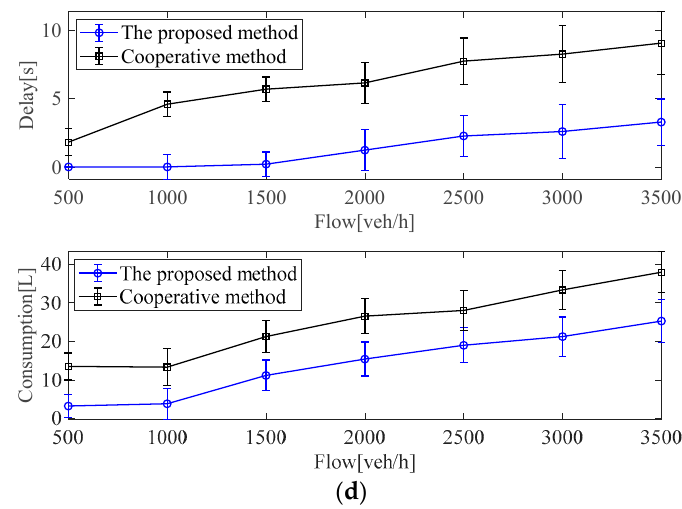
Figure 10. Test results with two methods under different traffic flow conditions in the intersection subregions: ( a ) test results in the intersection subregion N5; ( b ) test results in the intersection subregion N6, ( c ) Test results in the intersection subregion N7, ( d ) Test results in the intersection subregion N8.